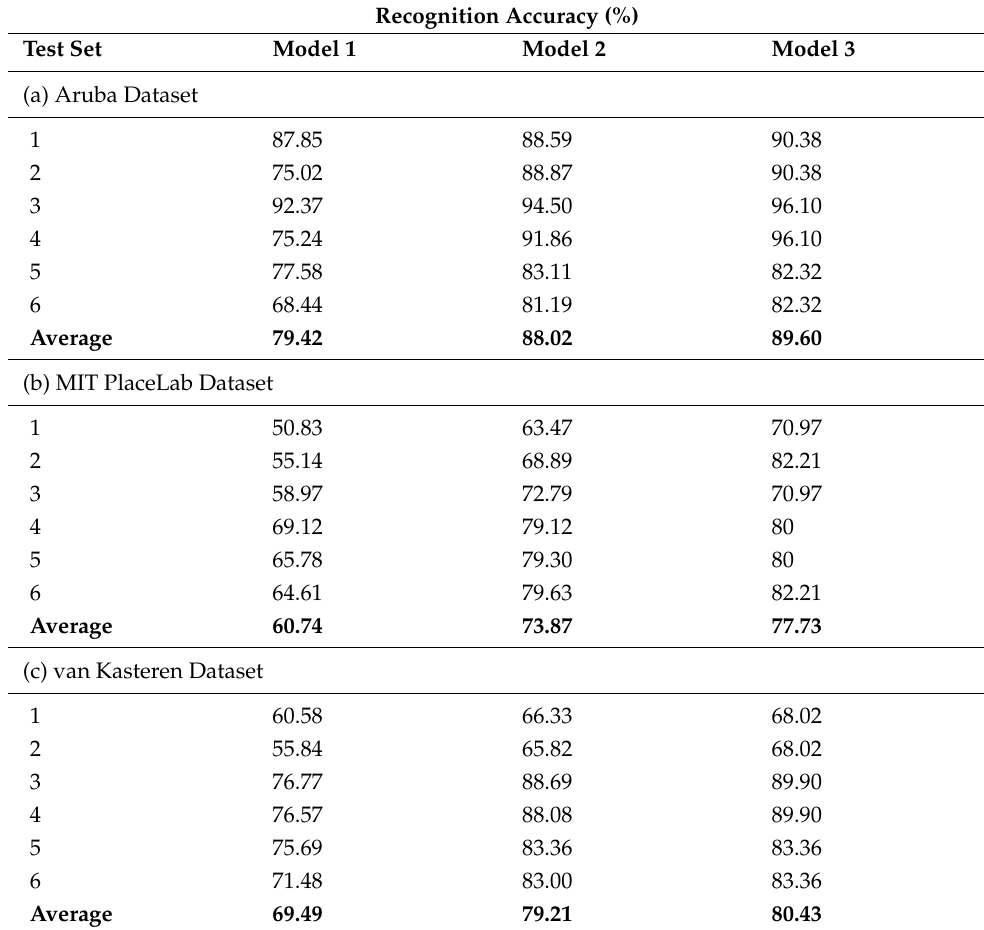
Table 5. Recognition performance for ( time , location ) → activity